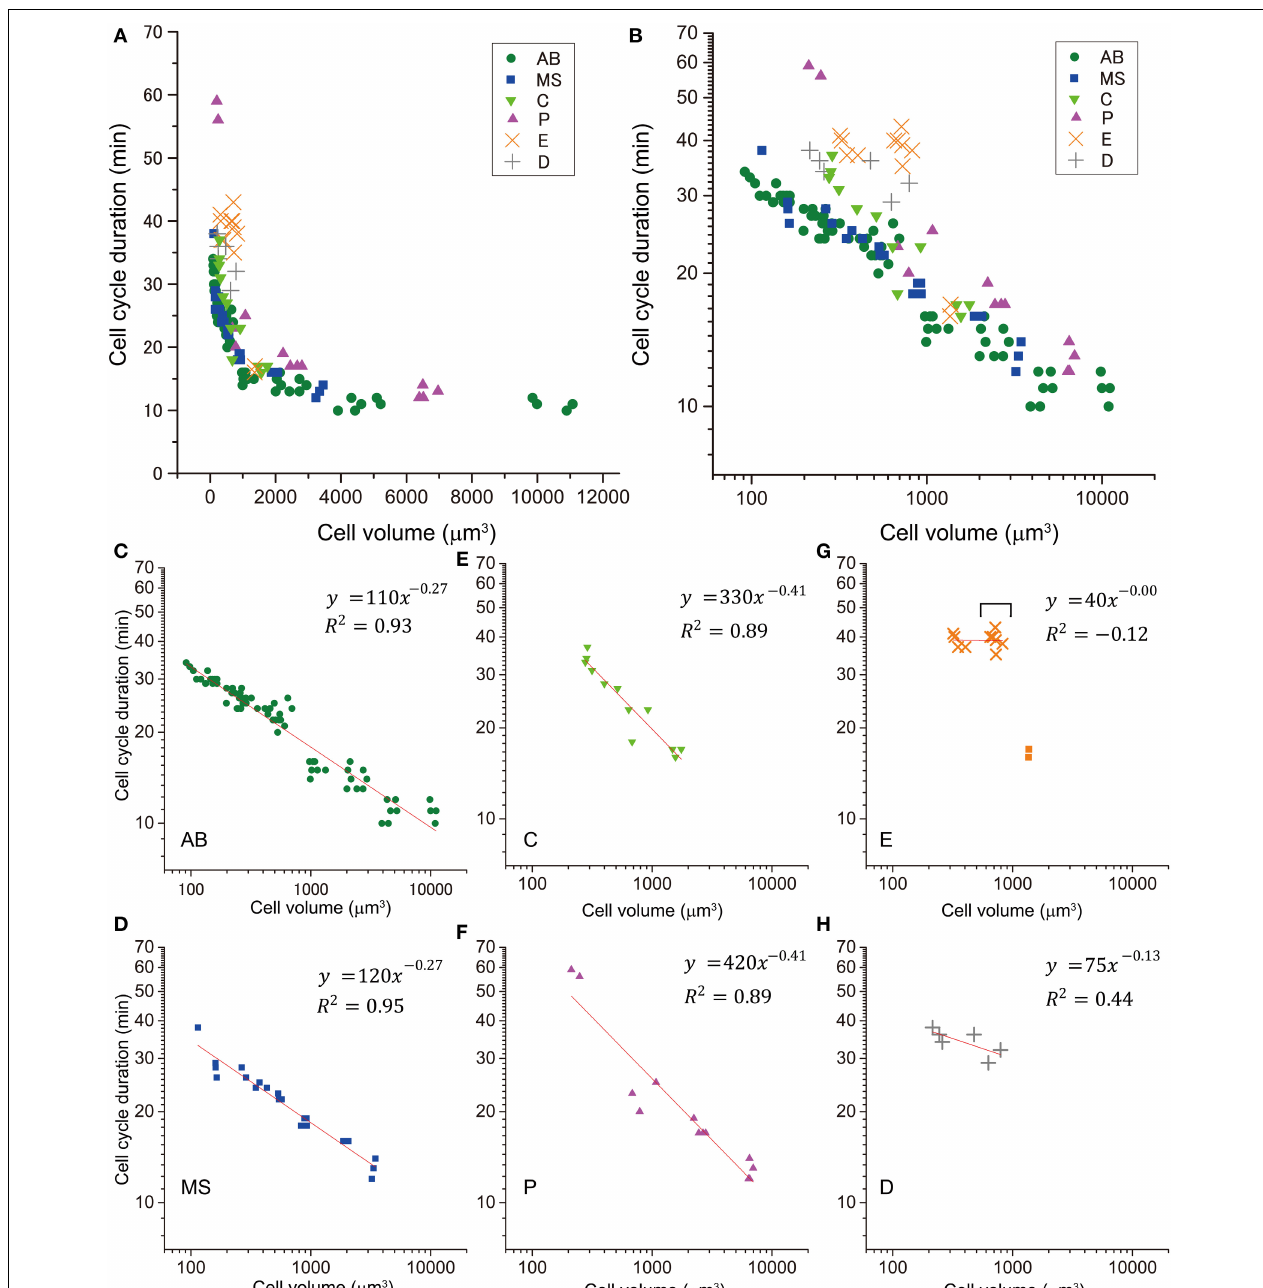
FIGURE 2 | Relationship between cell cycle duration and cell volume. This relationship of cells in embryos is shown in a double logarithmic plot (A) and a linear plot (B) . The relationship of cells in AB [green dot, (C) ], MS [blue square, (D) ], C [light green triangle, (E) ], P [magenta triangle, (F) ], E [orange x-mark, (G) ], and D [gray cross, (H) ] lineages are shown in the double logarithmic plot. Cell volume and cell cycle duration data were obtained from